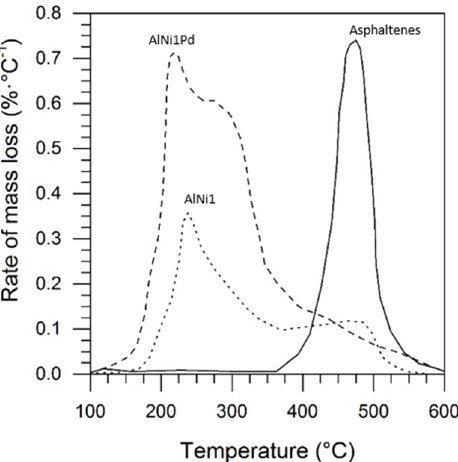
Figure 7. Rate of mass loss for non-catalyzed and catalyzed n -C 7 asphaltene gasification by AlNi1 and AlNi1Pd1 nanoparticles.